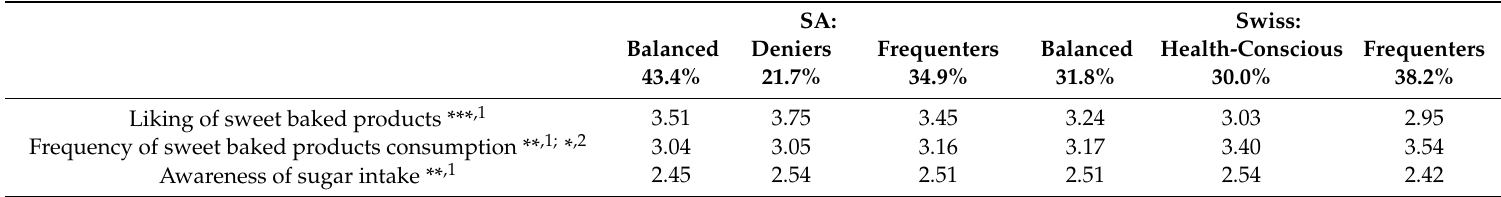
Table 3. Mean scores on the clustering scales and contrast analysis results by clusters of consumers’ liking and frequency of consumption of SBPs. SA: Swiss: Balanced Deniers Frequenters Balanced